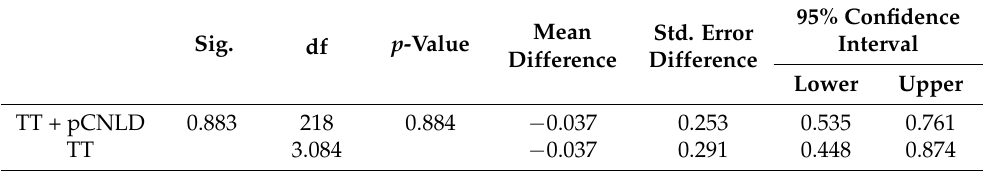
Table 5. Positive lymph nodes connected with diseases